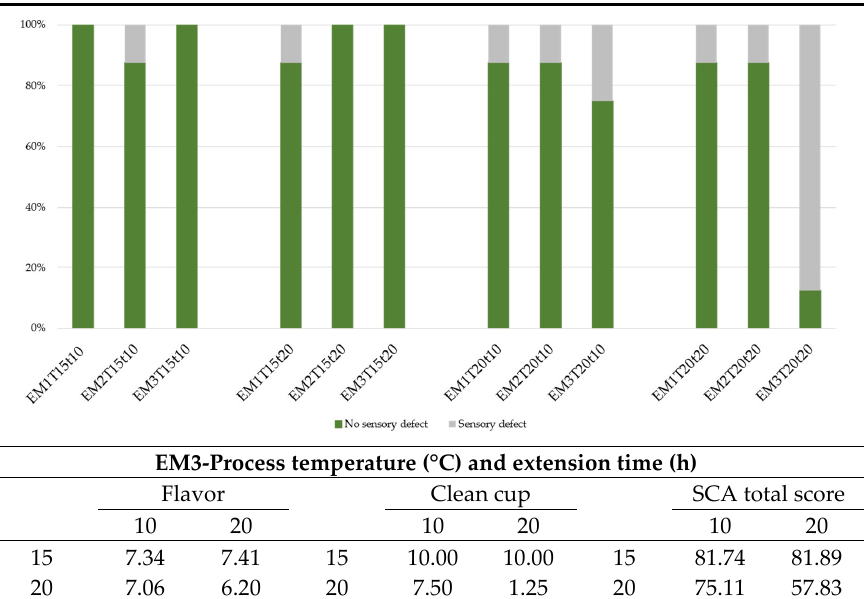
Figure 6. Effect of prolonged mucilage fermentation on the sensory quality of coffee according to Duncan’s test (α = 0.05).